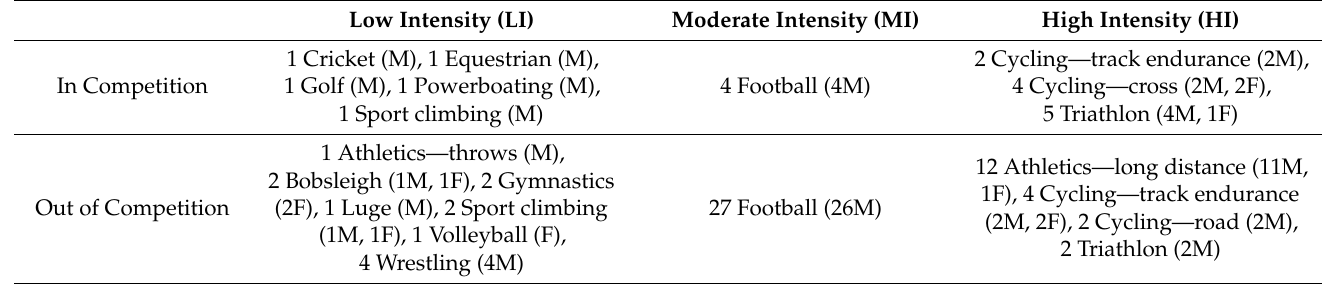
Table 1. Classification of participants. Participating elite athletes (males: M and females: F) were divided into three groups depending on the intensity of their sports, and further dichotomized into In Competition and Out of Competition categories depending on timing of sample collection. Low Intensity (LI) Moderate Intensity (MI) High Intensity